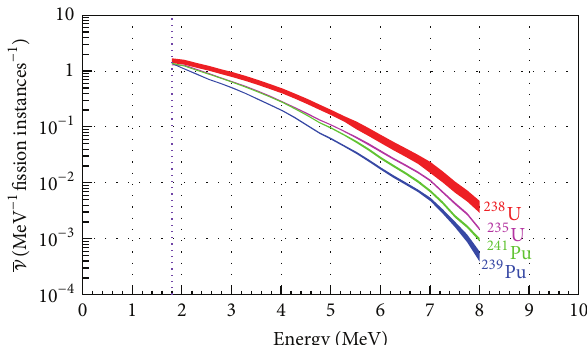
Figure 5: Energy spectra of the emitted antineutrinos per fission of 235 U, 238 U, 239 Pu, and 241 Pu. The dotted line at 1.8 MeV indicates the threshold for the Inverse Beta Decay (IBD)